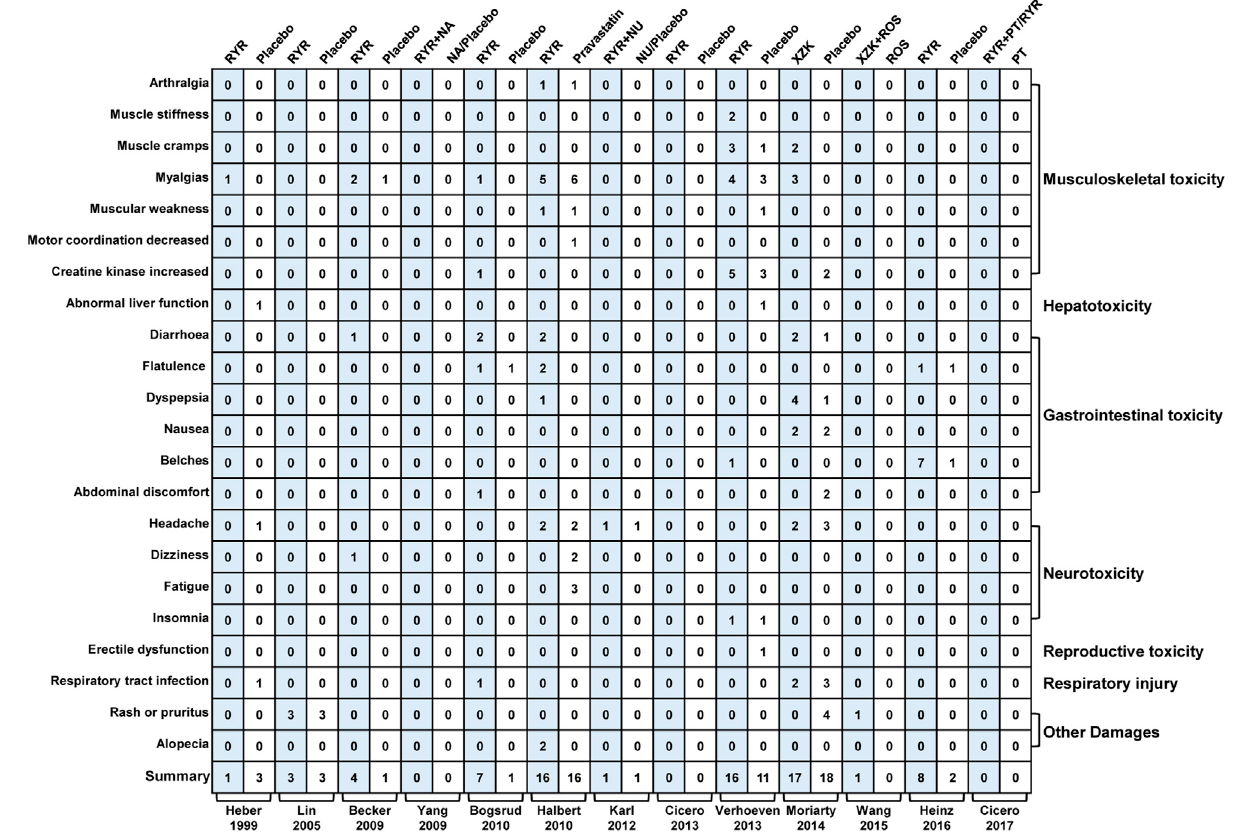
Frontiers in Pharmacology |